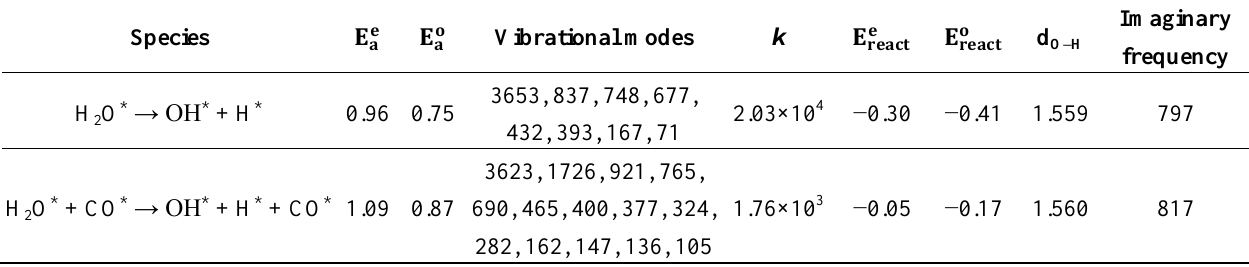
Table 2. Activation energies (eV), vibrational frequencies (cm −1 ), reaction rate constant at 463 K (s −1 ), reaction energy (eV), length of the breaking OH bond at the transition state and its imaginary frequency (cm −1 ), with and without co-adsorbed carbon monoxide. a